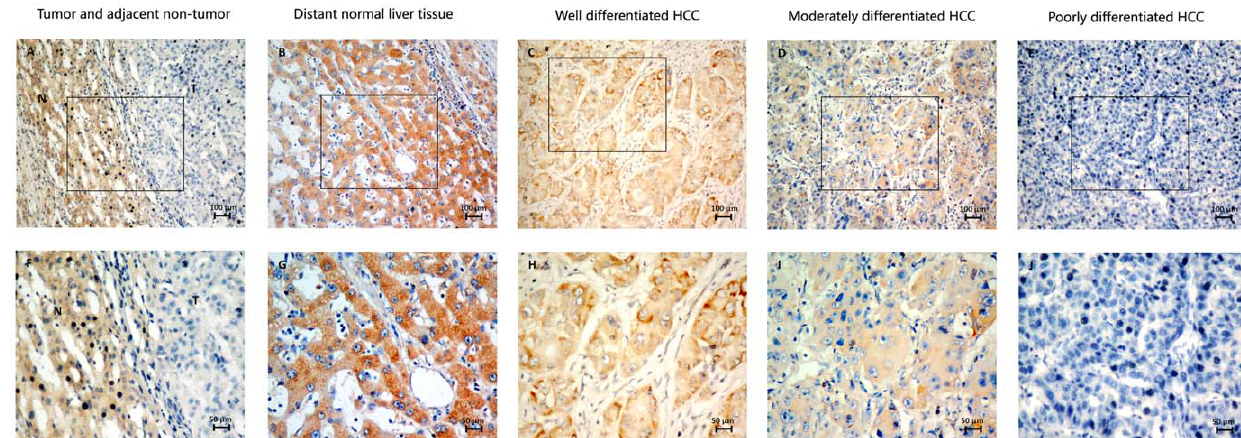
Figure 2. Immunohistochemical analysis of the LZAP protein expression in the primary hepatocellular carcinoma surgical specimens. ( A ) and ( F ) Immunostaining of an HCC tumor and the adjacent non-tumorous area. ( B ) and ( G ) Normal liver tissue distant from the tumor, scored as LZAP ( +++ ). ( C ) and ( H ) Well-differentiated HCC, scored as LZAP ( ++ ). ( D ) and ( I ) Moderately differentiated HCC, scored as LZAP ( + ). ( E ) and ( J ) poorly differentiated HCC, scored as LZAP ( 2 ). N: non-tumor tissue; T: tumor tissue (A–E with 200 6 magnification; F–J with 400 6